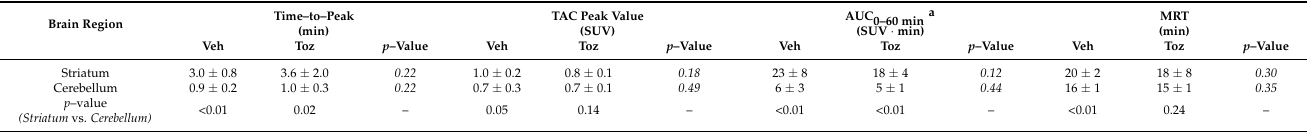
Table 1. Non–compartmental pharmaokinetic parameters derived from the time–activity curves tozadenant (toz, n = 4) pre–treatment.